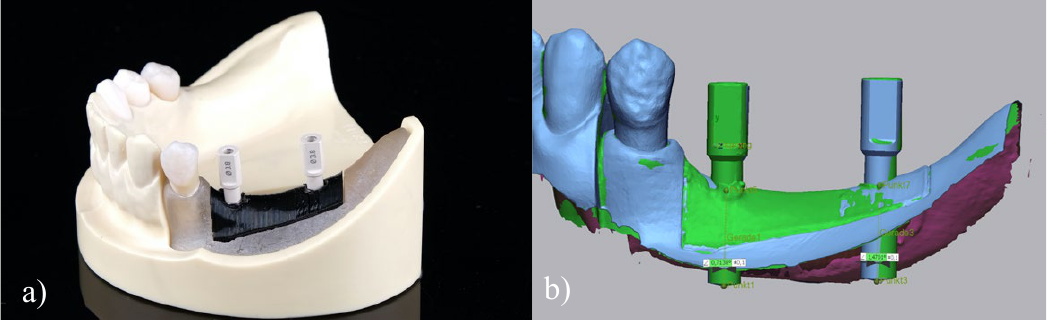
Figure 2. Digitization of the scan bodies: ( a ) Scan bodies in situ (implant final position), ( b ) Superimposition of planned and final position.